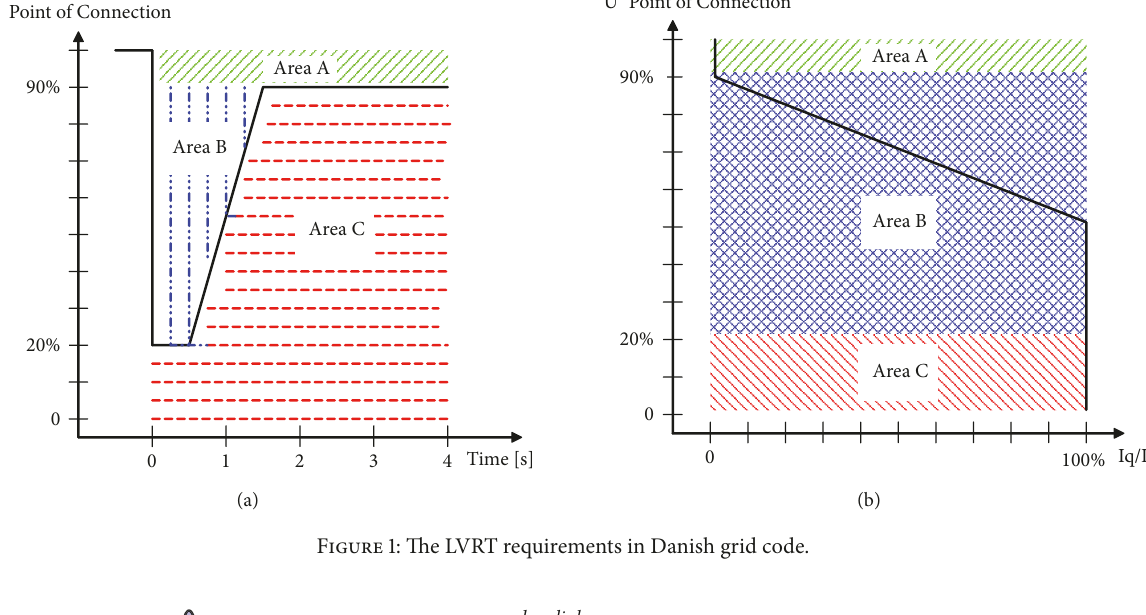
Figure 1: The LVRT requirements in Danish grid code.